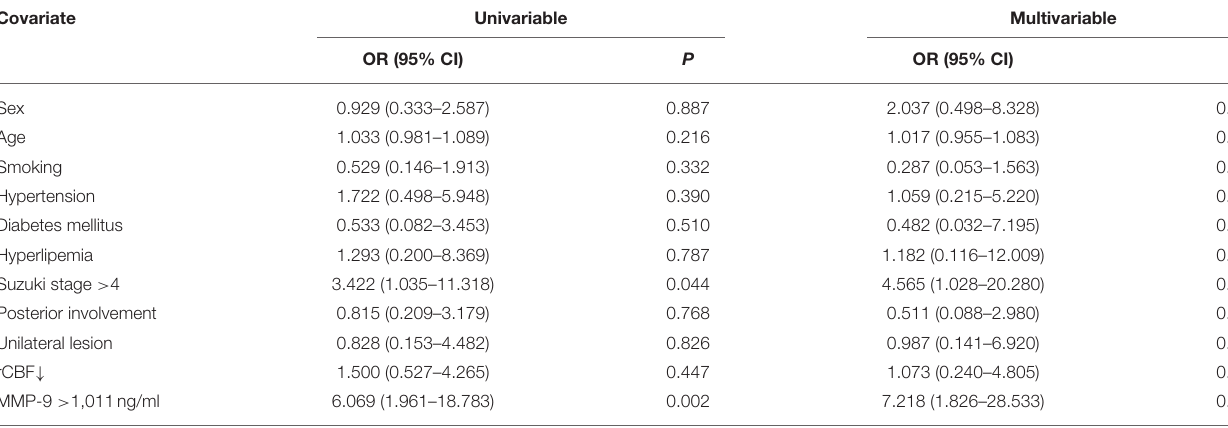
TABLE 3 | Logistic regression analysis of predictors for spontaneous hemorrhages in adult patients with moyamoya disease.